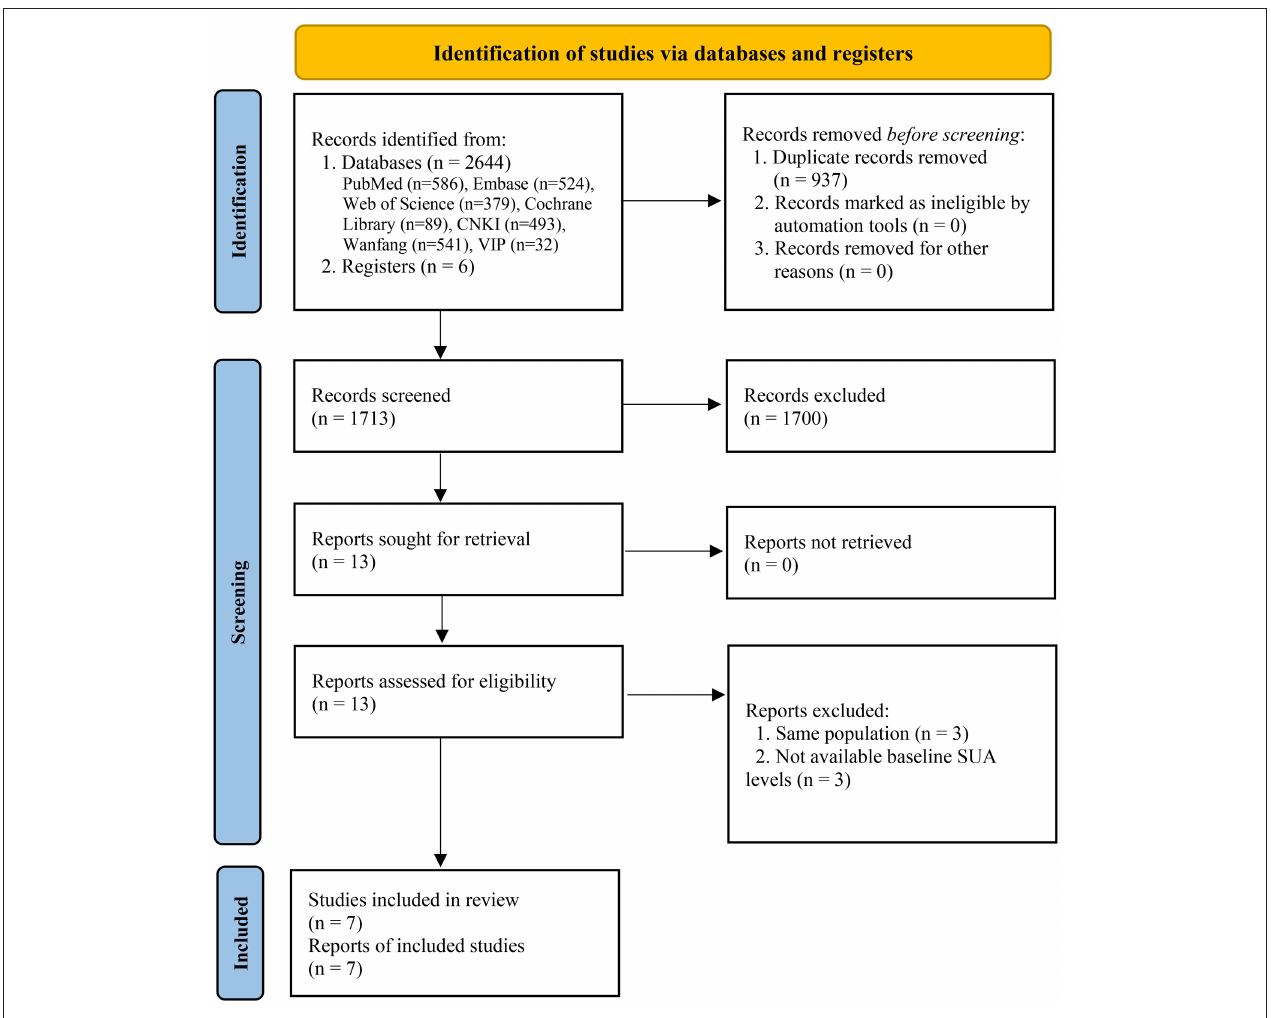
FIGURE 1 | Flow diagram of systematic literature